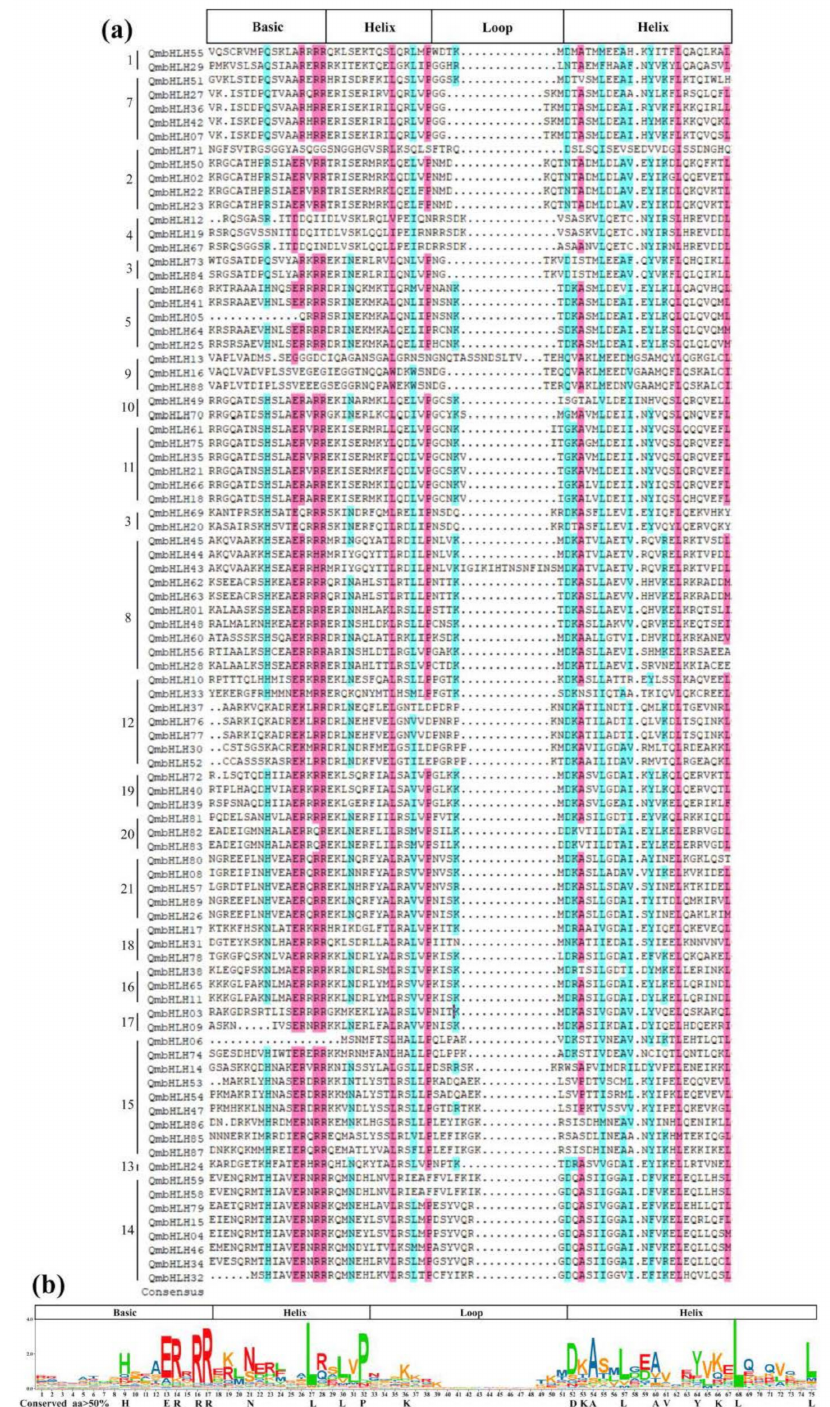
Figure 2. Multiple sequence alignment of amino acid sequences of the conserved structural domains of QmbHLH proteins from Q. mongolica . ( a ) Multiple sequence alignment of QmbHLH proteins.